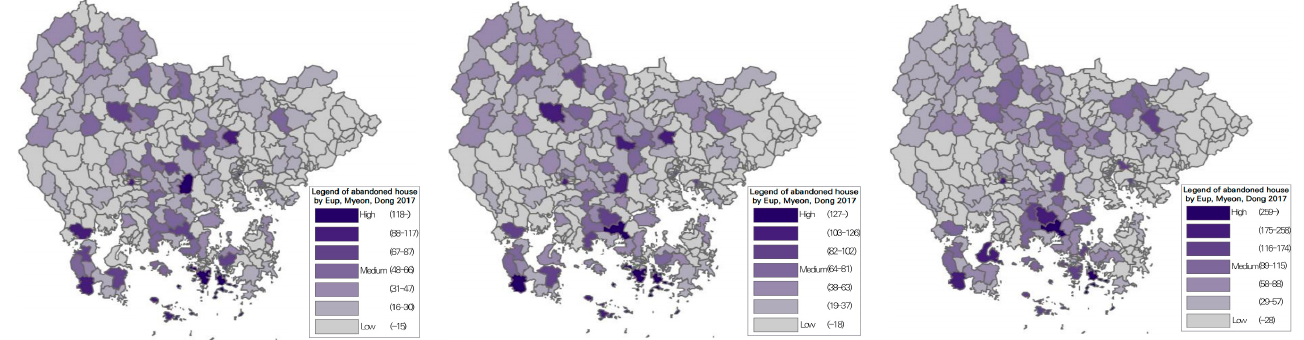
Figure 2. Abandoned houses in submunicipal divisions in Gyeongsangnam-do (2017–2019).